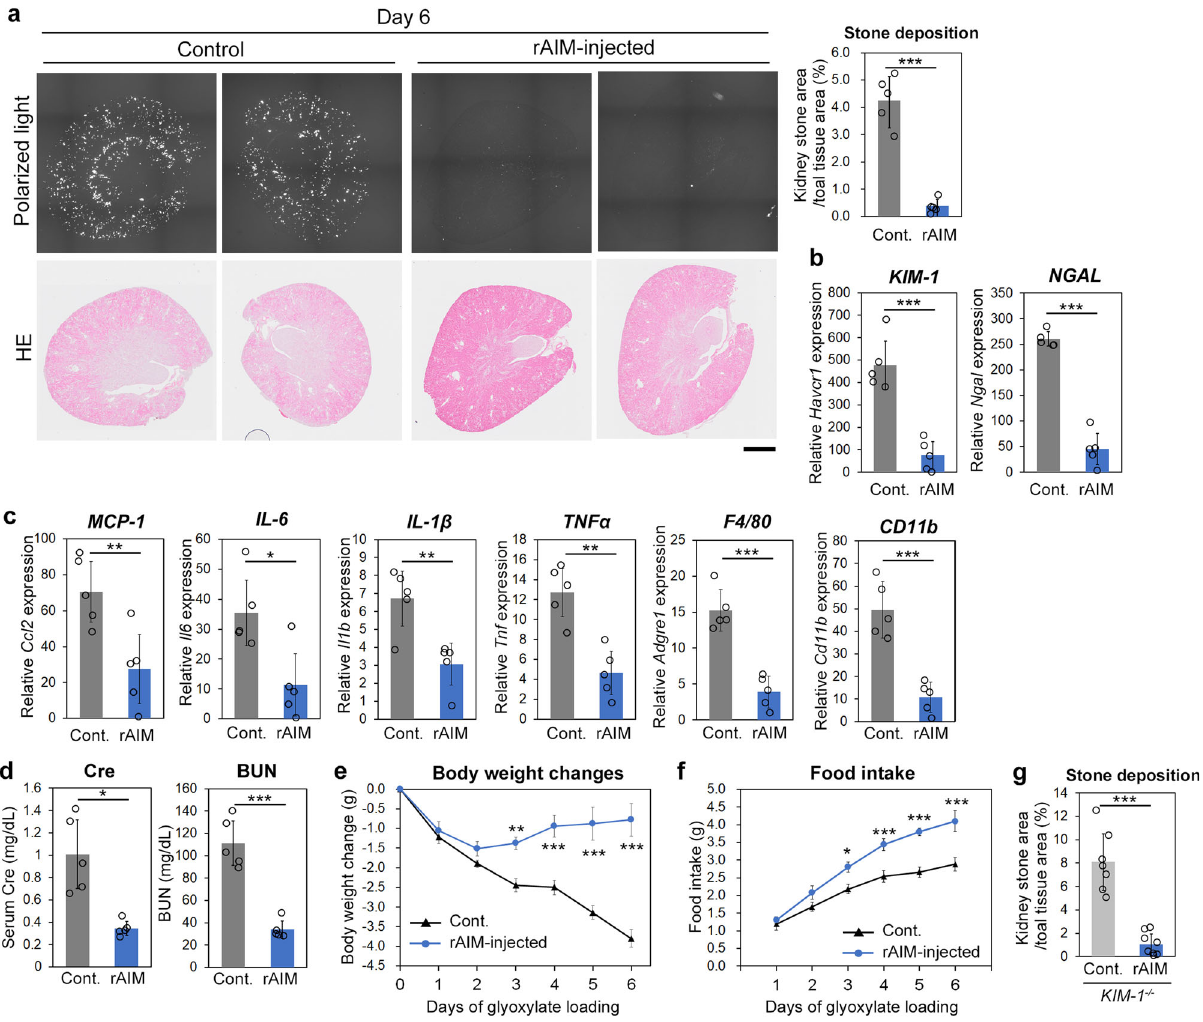
Fig. 1 rAIM prevents kidney stone development. a The amount of kidney stones in rAIM-injected (400 µ g; n = 5) and PBS-injected ( n = 5) mice on day 6 of glyoxylate loading. The number represents the percentage of stone area in the whole kidney section. Scale bar: 1 mm. The average stone area in three non-serial sections for each mouse is plotted. b , c Quantitative PCR analysis of the mRNA levels of kidney injury markers, Haver1 ( KIM-1 ) and Ngal ( b ), and various pro-in fl ammatory genes and macrophage marker genes ( c ) in the kidney of the mice above. d Serum Cre and BUN levels. e Bodyweight changes. Values are relative to those before glyoxylate loading. f Daily food intake. g The amount of kidney stones in rAIM-injected ( n = 7) and PBS-injected ( n = 8) KIM-1 − / − mice on day 6 of glyoxylate loading. Means ± s.d. ( a – d , g ) or s.e.m ( e , f ) are shown. Statistical analysis was performed using Welch ’ s t -test ( a – d , g ) or repeated measures ANOVA ( e ,